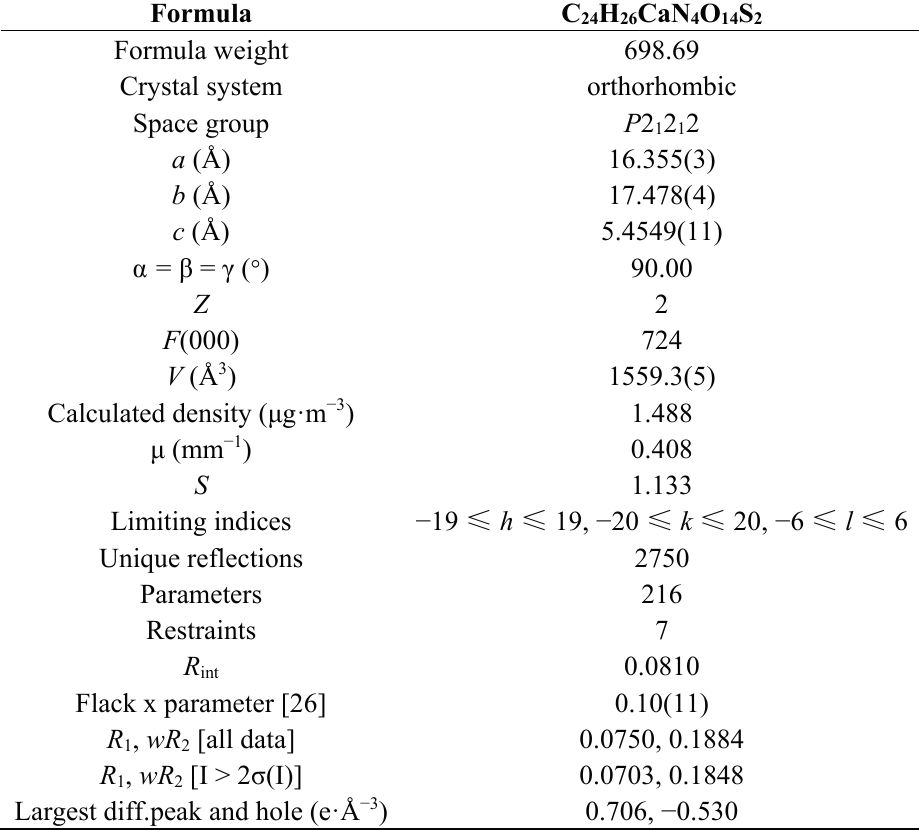
Table 2. Crystal data for 1 .